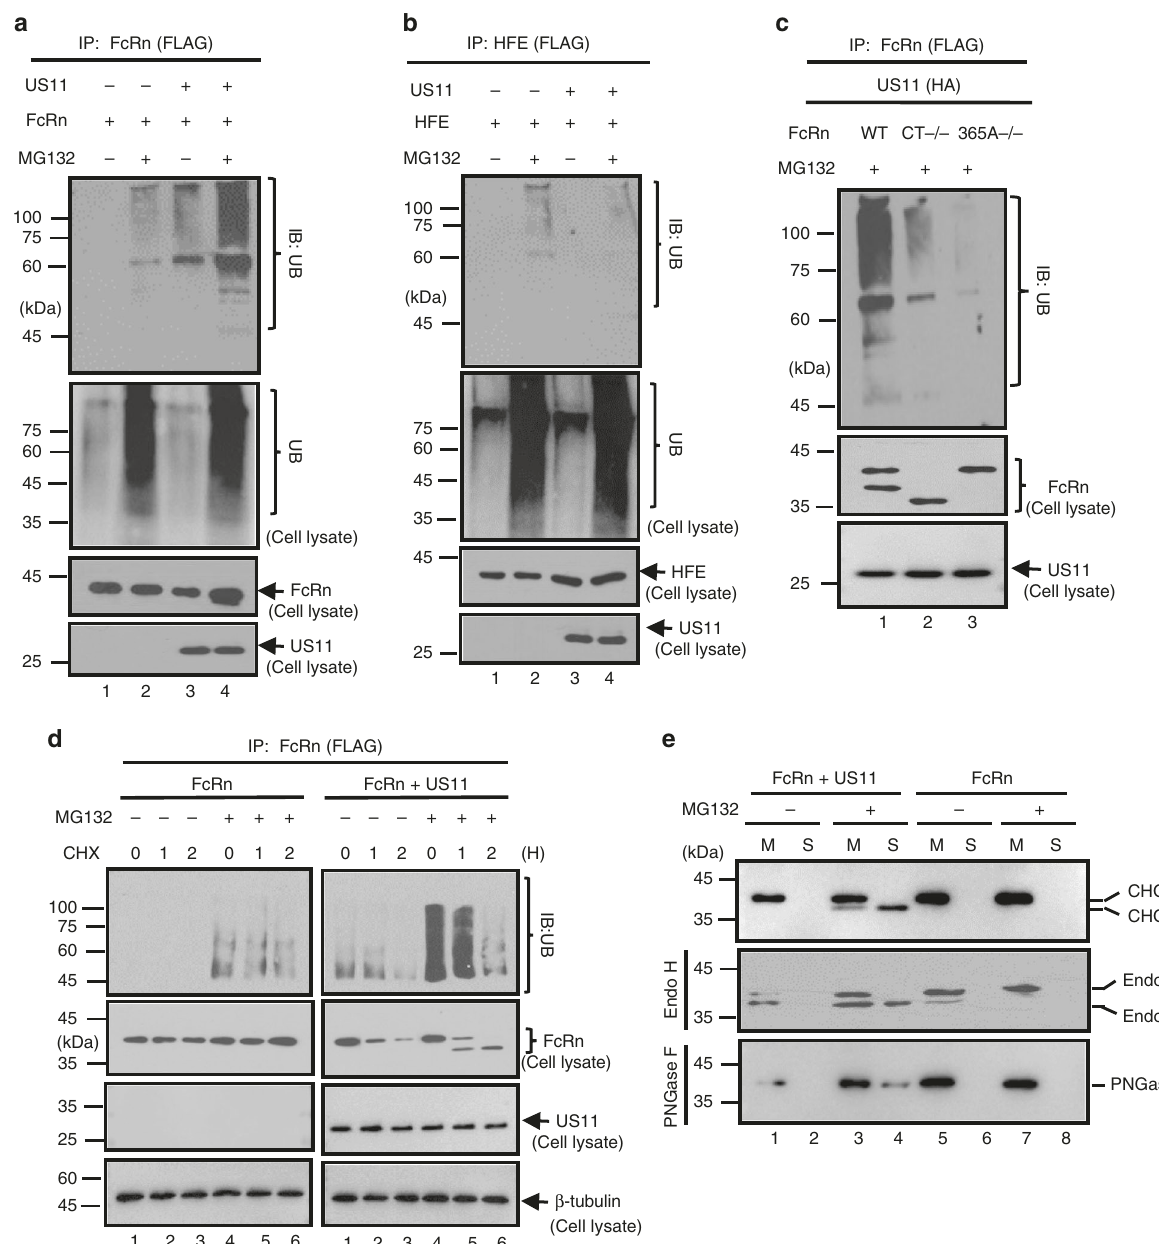
Fig. 6 US11 induces FcRn dislocation and ubiquitylation. a – d FcRn is ubiquitinated in the presence of US11 and MG132. HeLa FcRn ( a ), HeLa HFE ( b ), HeLa FcRn CT − / − ( c , lane 2), and HeLa FcRn 365A − / − ( c , lane 3) cells were transfected with or without US11 plasmids for 48 h, and cells were treated with proteasome inhibitor MG132 (50 μ M) for 2 h, as indicated. HeLa FcRn or HeLa FcRn + US11 cells ( d ) were treated with CHX (100 μ g/ml) and chased for the indicated time in the presence of MG132. Cell lysates (0.5 mg) were immunoprecipitated with mAb anti-FLAG for FcRn ( a , c , d ) or HFE ( b ). All immunoprecipitates or cell lysates (20 μ g) as internal controls were subject to western blotting with corresponding Abs as indicated. e Fractionation of FcRn HC. HeLa FcRn , HeLa US11 + FcRn cells were incubated in the presence or absence of 50 μ M MG132 for 4 h. Cells were then homogenized and the homogenates were fractionated by centrifugation (see Methods). FcRn in the membrane pellet (M, lanes 1, 3, 5, 7) and supernatant (S, lanes 2, 4, 6, 8) fraction was digested by mock (top), Endo-H (middle), PNGase F (bottom) enzymes for 2 h at 37 °C, respectively. R: resistant; S: sensitive. After treatment all fractions were subject to western blotting with corresponding Abs as